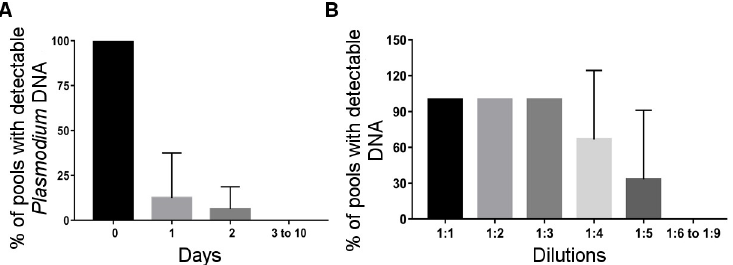
Fig 1. Standardization of Plasmodium DNA detection from engorged culicids. Plasmodium DNA was detectable at D2 post-feeding (A) and 1:5 mosquito pool size